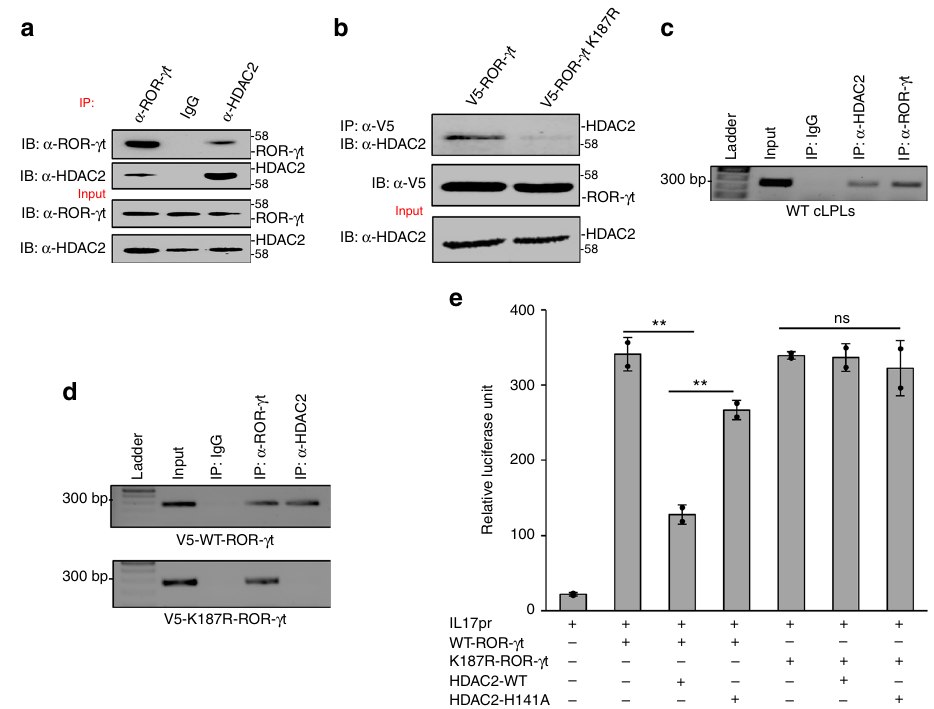
Fig. 4 SUMOylation facilitates HDAC2-to-ROR- γ t binding and inhibits IL-17 expression. a Lysates from cLPLs of WT mice were immunoprecipitated with anti-ROR- γ t, anti-HDAC2 antibody, or control IgG antibody and immunoblotted with antibody against ROR- γ t or HDAC2. b Transduced ROR- γ t – / – CD4 + T cells expressing either WT-ROR- γ t or the K187R-ROR- γ t were immunoprecipitated with anti-V5 antibody and immunoblot with antibody against V5 or HDAC2. c Binding of HDAC2 to the IL-17 promoter was assessed by ChIP analysis using a DNA-protein complex from cLPLs of WT mice that was immunoprecipitated with anti-ROR- γ t, anti-HDAC2, or control IgG antibody. d SUMOylation of ROR- γ t facilitates HDAC2 recruitment to the IL-17 promoter. ChIP analysis was conducted using DNA-protein complex from transduced ROR- γ t – / – CD4 + T cells expressing either WT-ROR- γ t or the K187R- ROR- γ t and immunoprecipitated with anti – ROR- γ t, anti-HDAC2, or control IgG antibody. e A luciferase assay was performed of lysates from Jurkat T cells transfected with various combinations (below plot) of IL - 17-promoter-driven luciferase plasmid (pGL4-mIL17p), plasmid encoding WT-ROR- γ t or K187R- ROR- γ t along with either HDAC2-WT or HDAC2-H141A. Results are presented in relative luciferase units (RLU). Data are from one experiment representative of three or more independent experiments with similar results. * p < 0.05 and ** p < 0.01, ns: non-signi fi cant (two-tail t test) error bars are